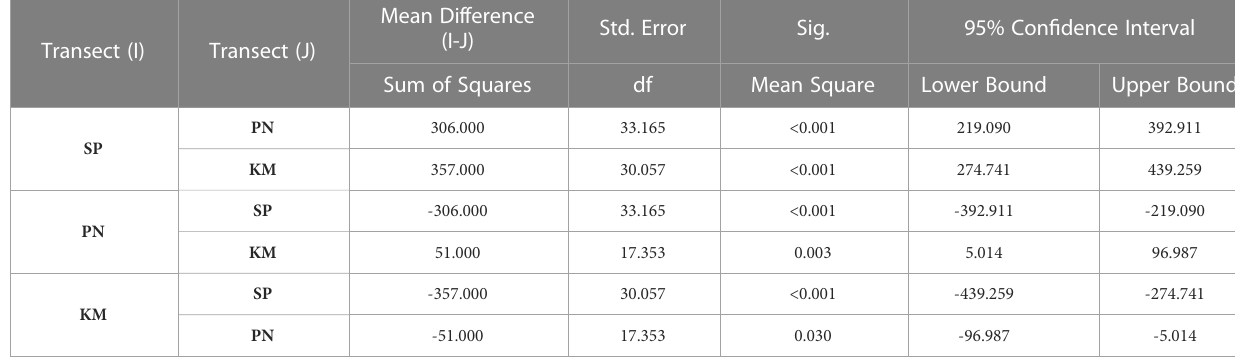
TABLE 4 Post-hoc test using Games-Howell analysis of MPs